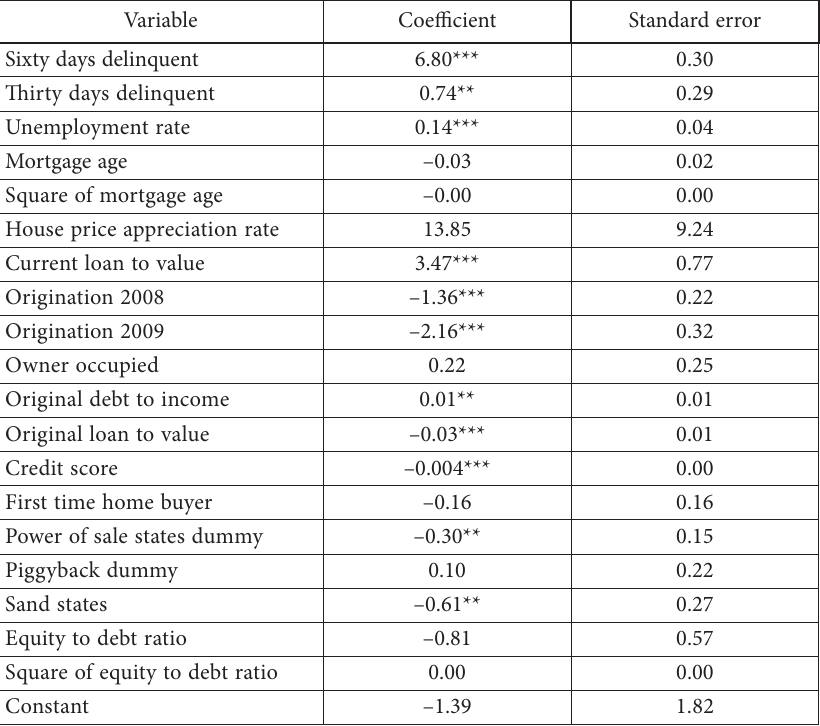
Table A.3. Estimation results: logit